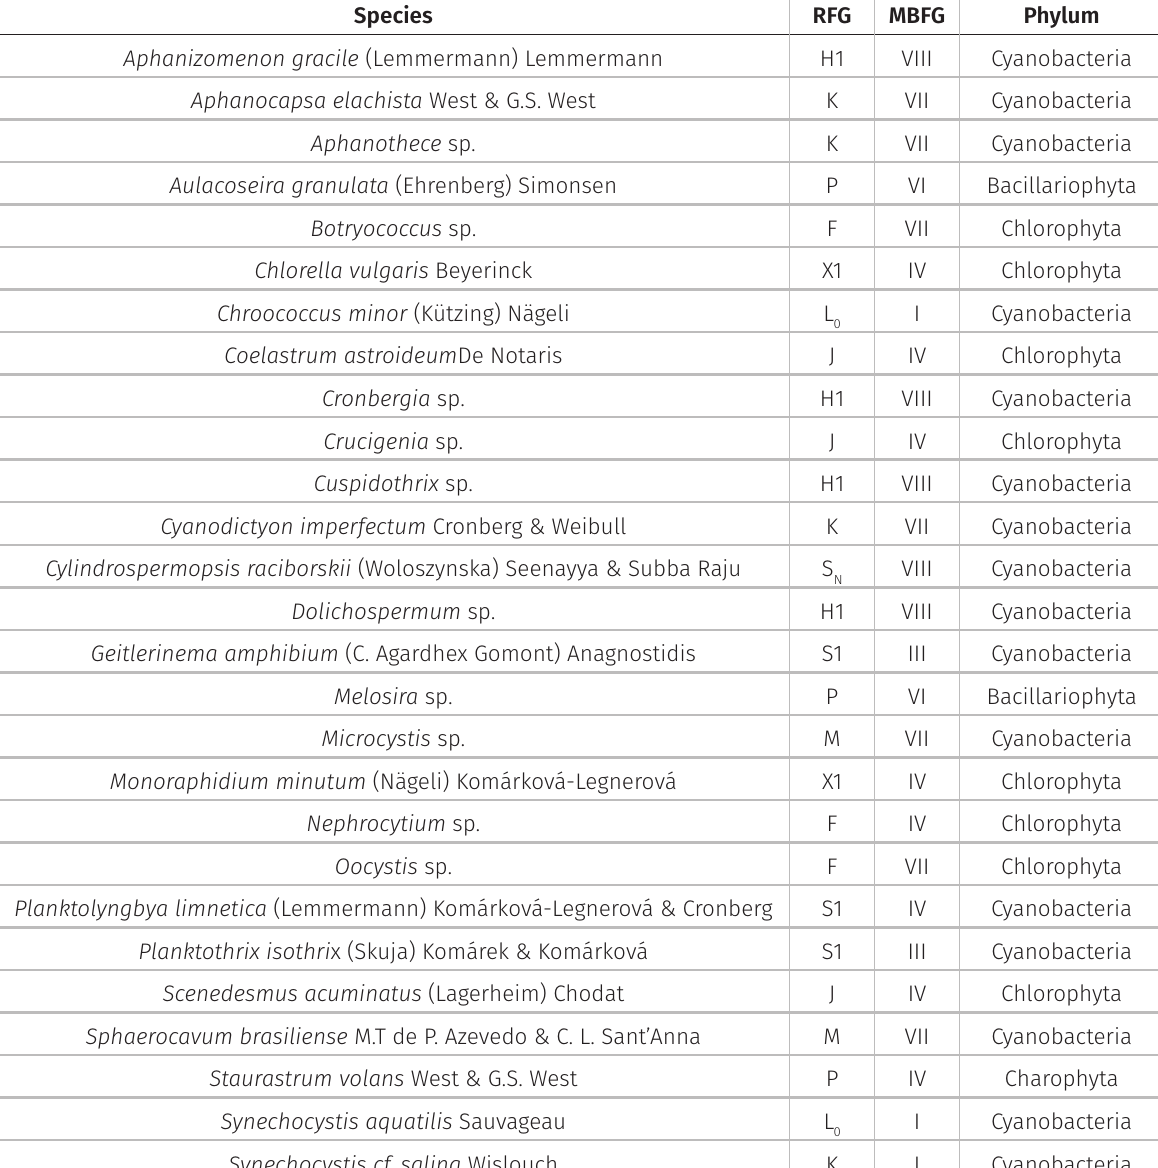
Table II. List of dominant taxa founded in Dourado reservoir and their Reynolds’ Functional Groups (RFG) and Morphology-Based Functional Groups (MBFG)